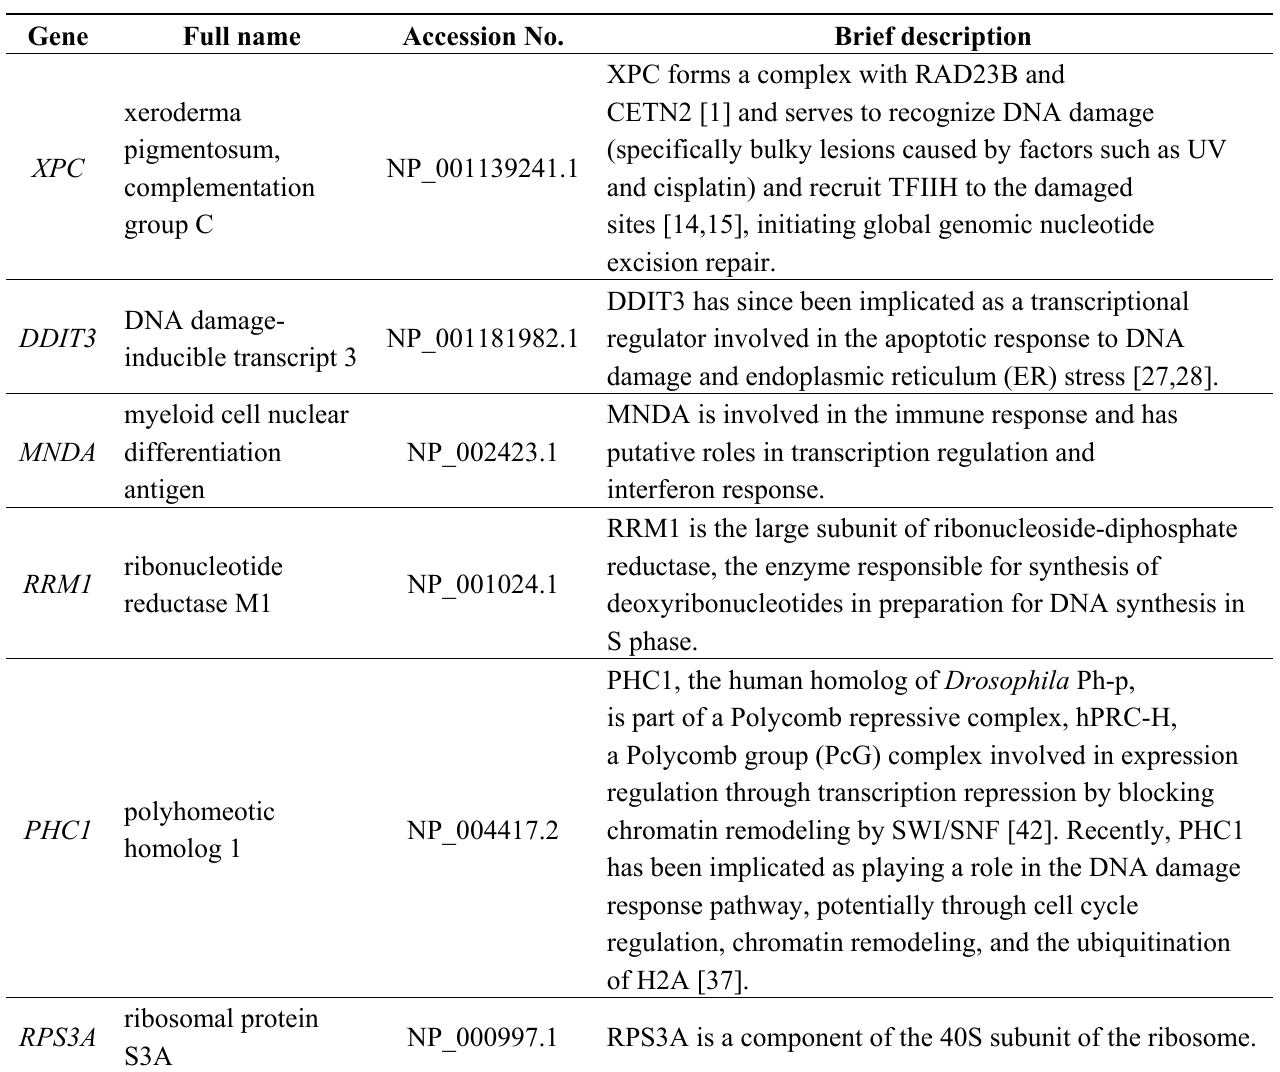
Table 1. DNA damage response and replication (6